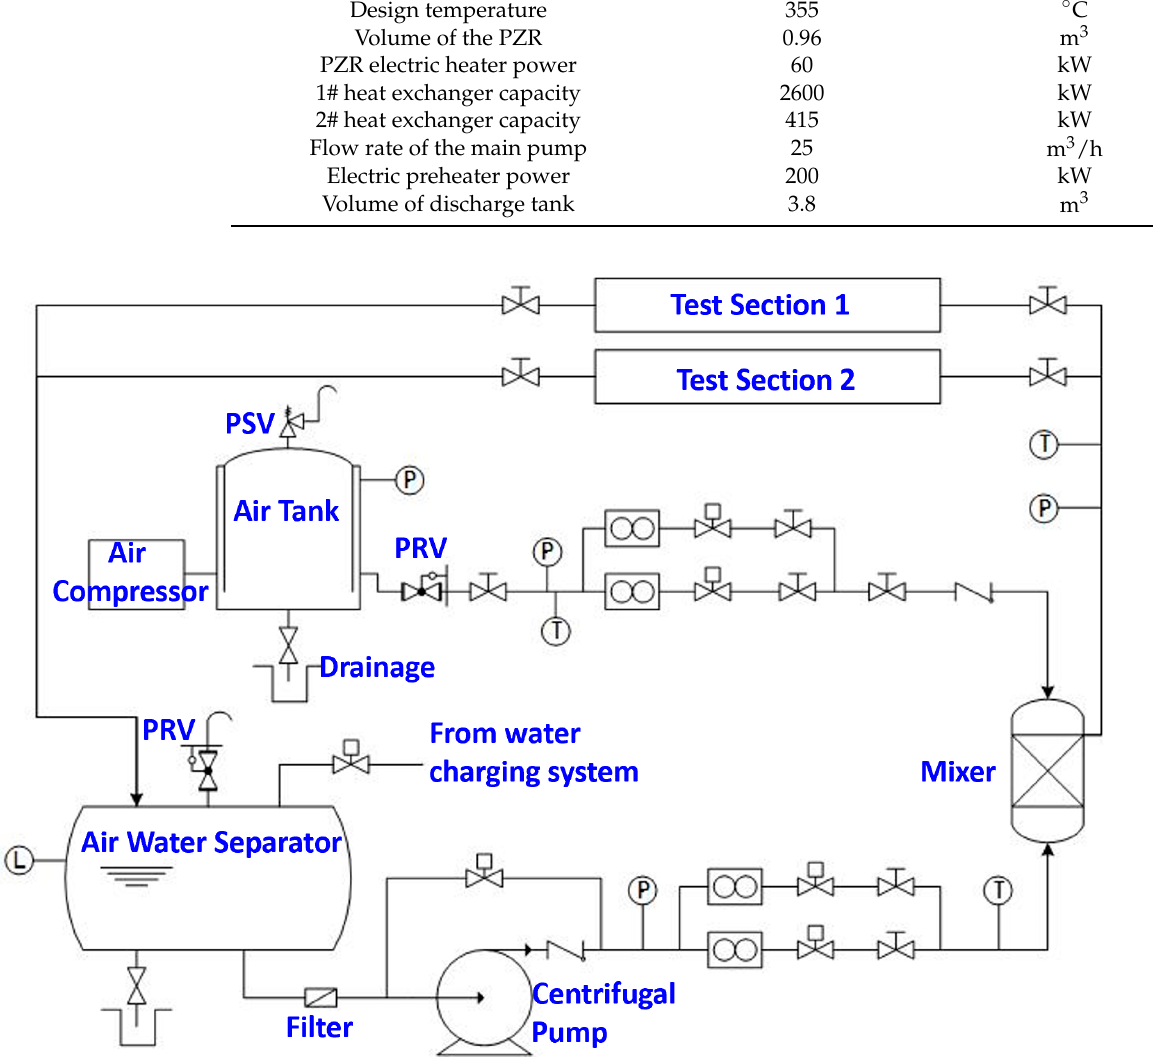
Figure 7. Scheme of the low pressure water loop.